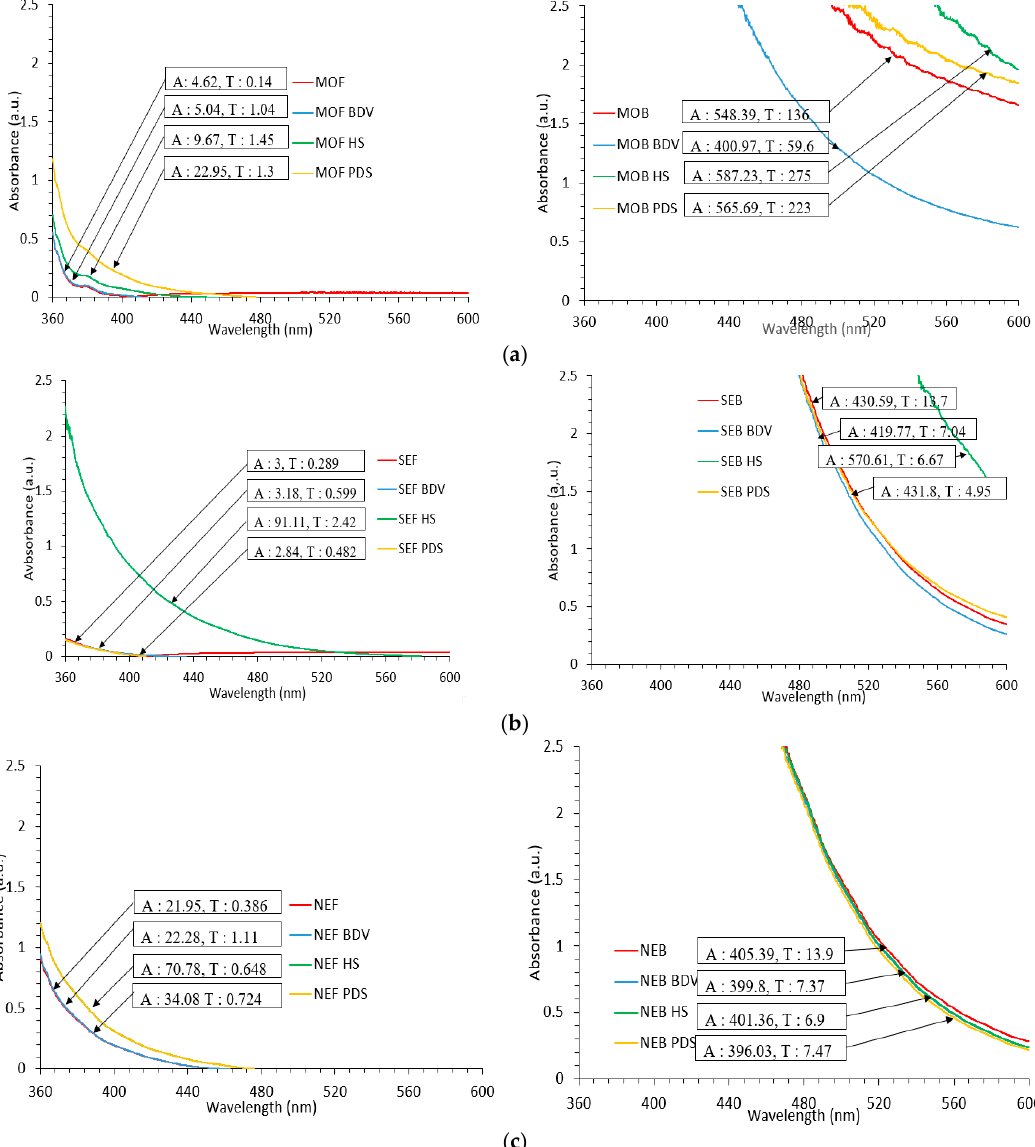
Figure 4. Illustration of the degradation of the investigated dielectric fluids under different fault conditions; ( a ) mineral oil; ( b ) synthetic ester; ( c ) natural ester.